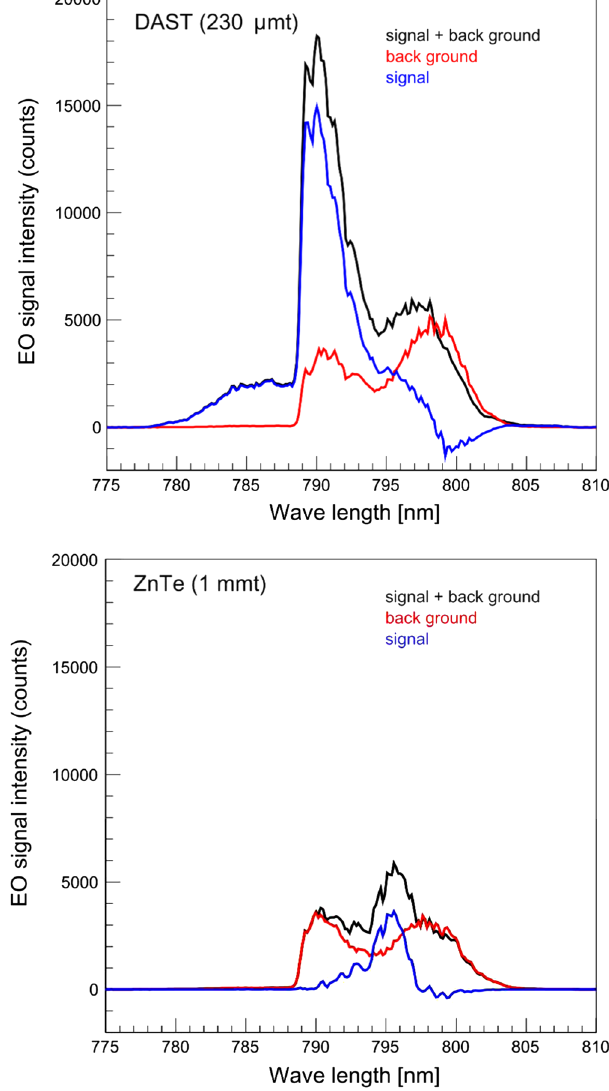
FIG. 8. Measured EO signal spectra with DAST (upper) and ZnTe (lower) crystals. For each figure, the original signal and background spectra measured by Ocean Optics, QE65000 spec- trometer are described as black and red, respectively. Blue curves are subtraction between signal and background spectra.